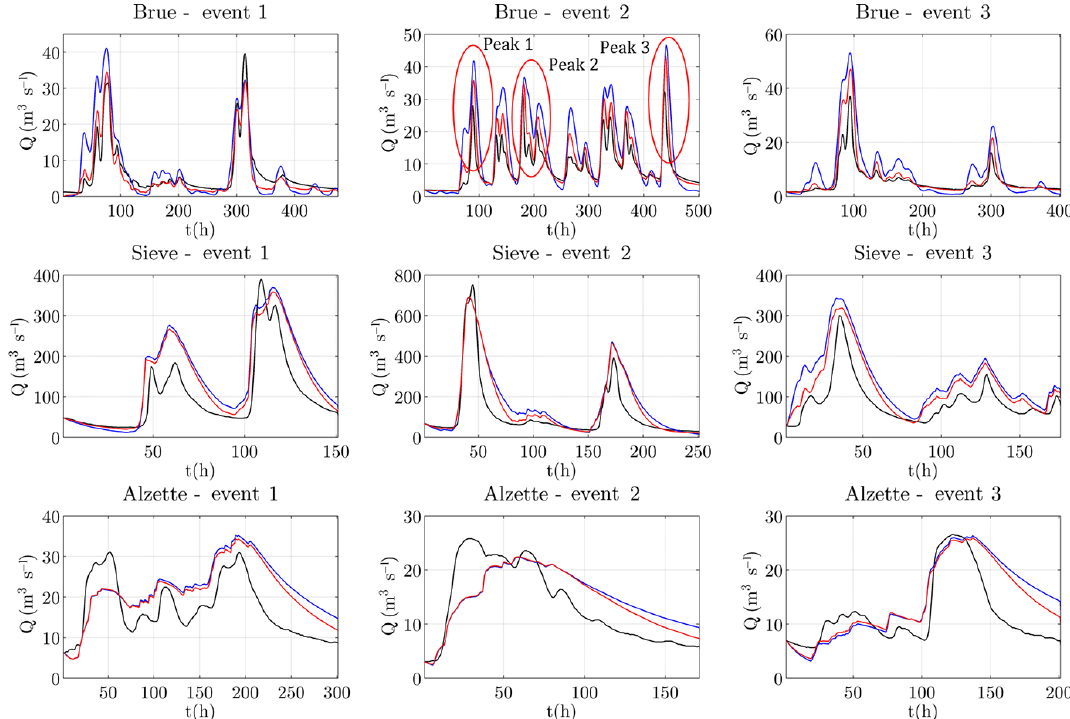
Figure 7. Observed (black line) and simulated hydrographs, with (red line) and without (blue line) assimilation, for the flood events which occurred in the three catchments: Brue (upper row), Sieve (middle row), and Alzette (bottom